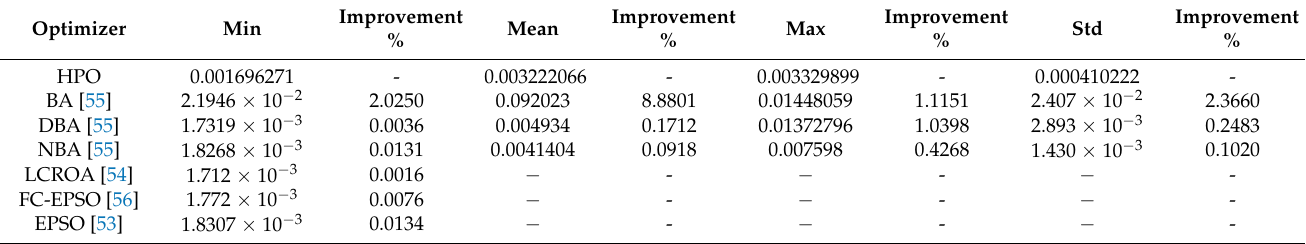
Table 4. Statistical analysis of HPO and other techniques for the double-diode model of STM6_40/36.